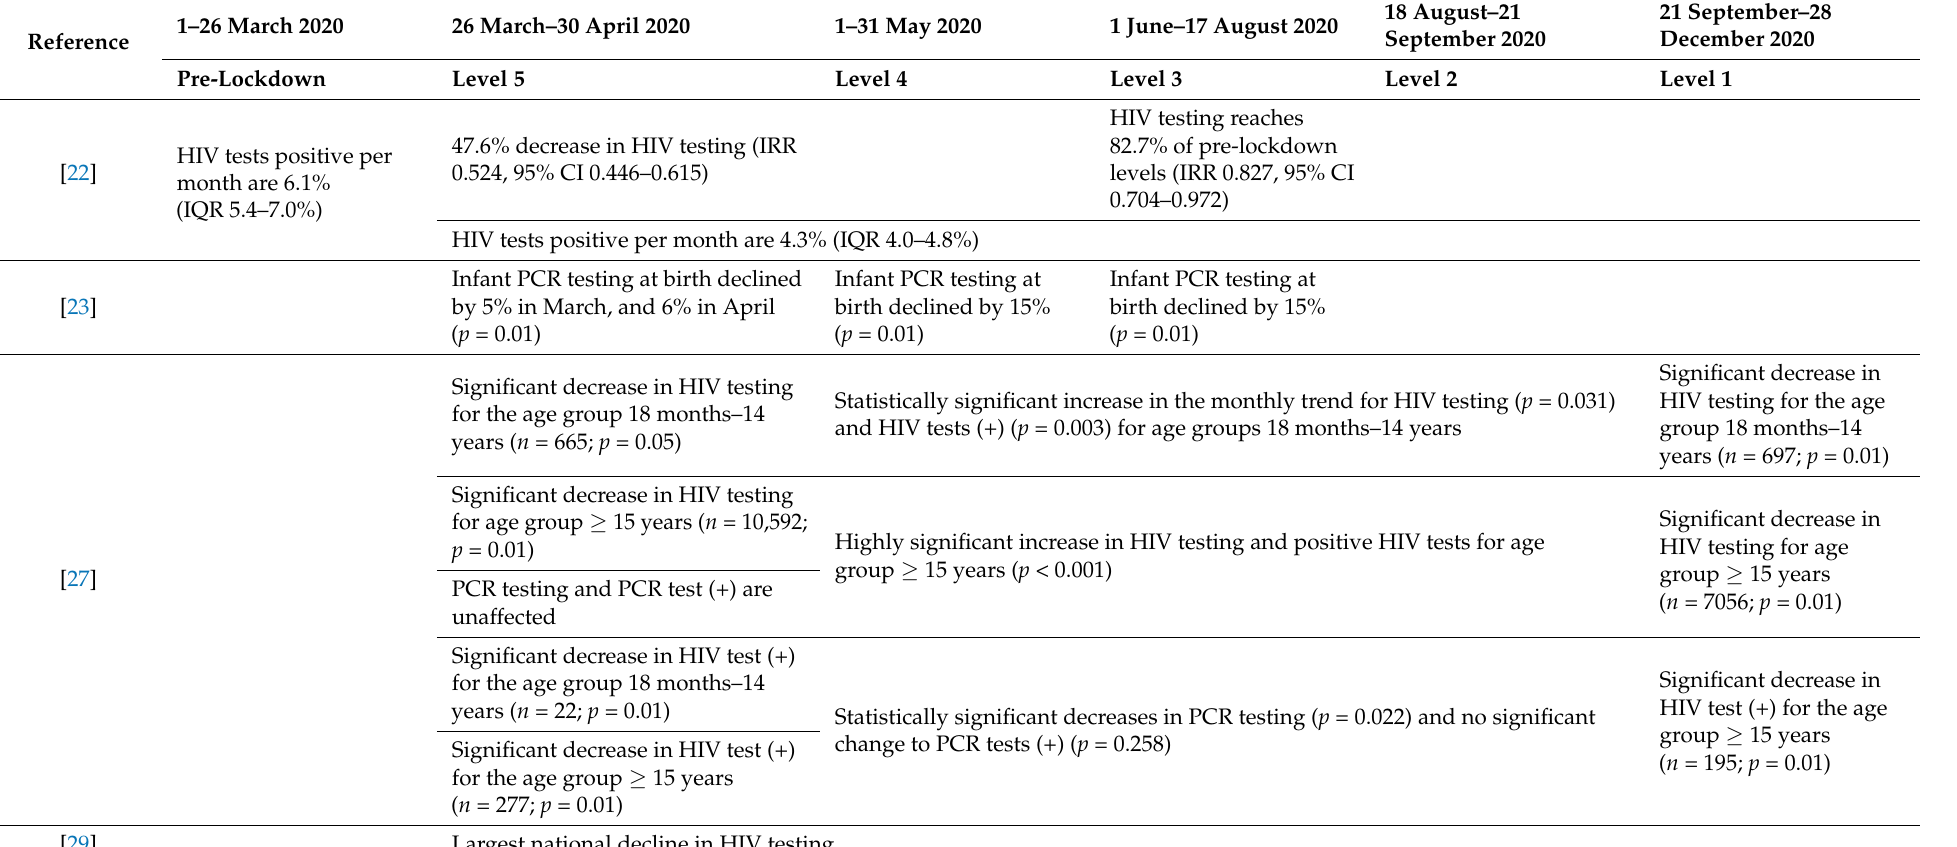
Table 3. This table summarises the changes in HIV testing services in chronological order, from before lockdown, to during lockdown. Data are expressed by incidence rate ratio (CI 95%), or the interquartile range is given. (IQR = Interquartile Range; IRR = Incidence Rate Ratio; CI = Confidence Interval; HIV = Human Immunodeficiency Virus; PCR = Polymerase Chain